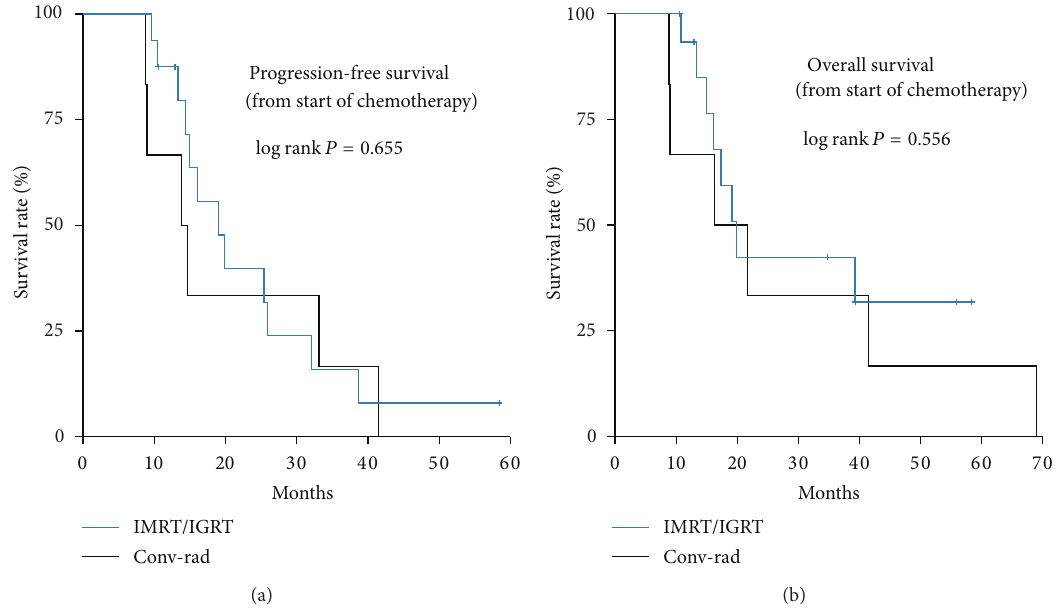
Figure 3: PFS and OS IMRT/IGRT versus conventional radiotherapy calculated from the start of palliative chemotherapy.